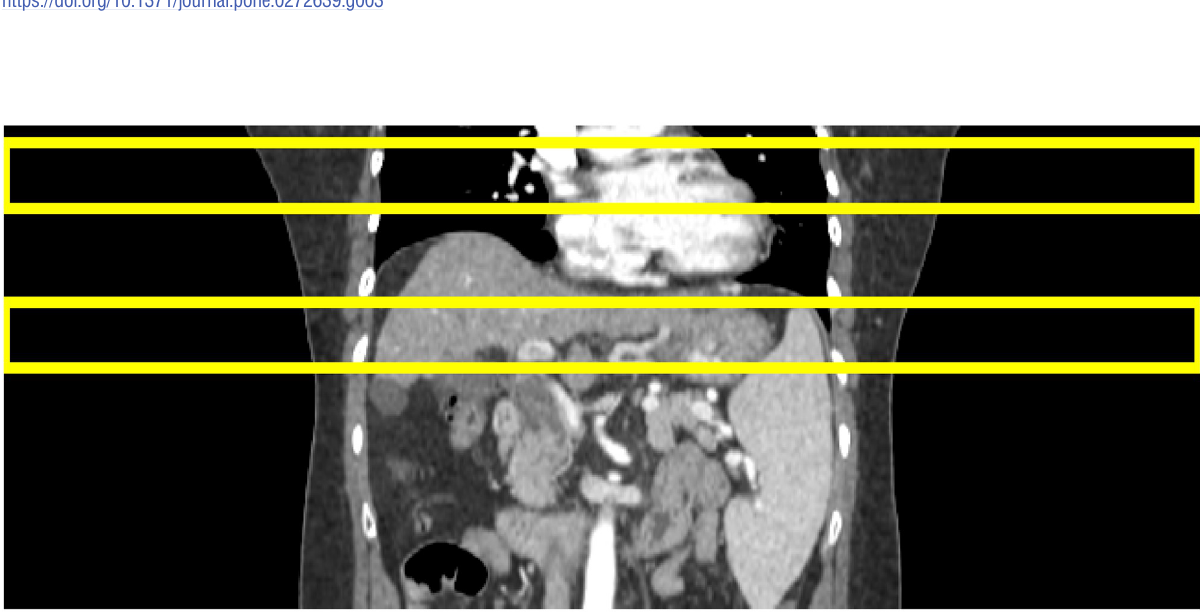
Fig 4. Evaluation regions of quantitative indicators for RMA in coronal view of BHCT. Top: Thoracic region; Bottom: Abdominal region.